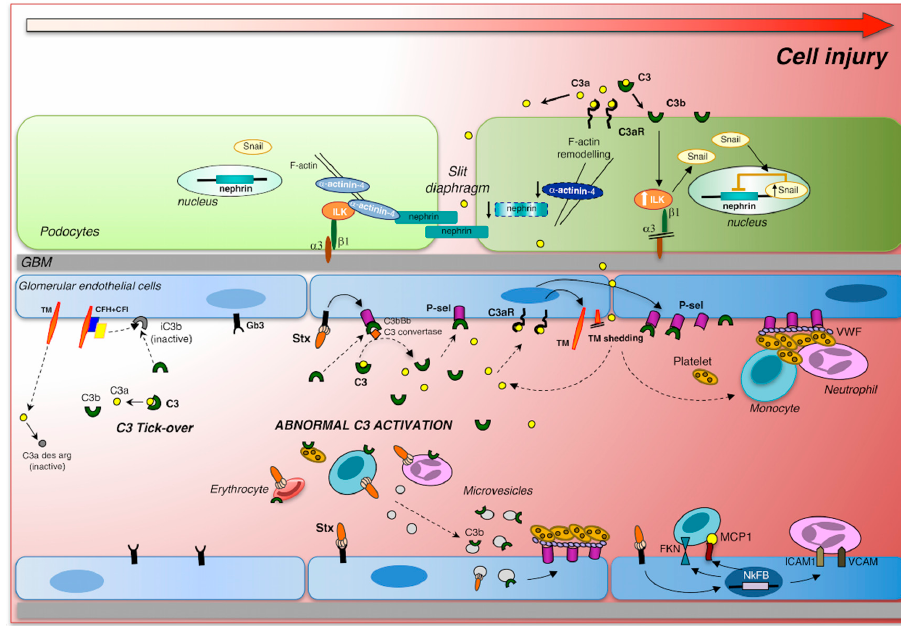
Figure 1. Intracellular signaling triggered by Shiga toxin (Stx) and complement activation in glomerular endothelial cells and podocytes. Stx binds to its specific Gb3 receptor and alters glomerular endothelial cell thromboresistance triggering a cascade of events that lead to microvascular thrombosis. Stx induces the release of thrombomodulin (TM) from the endothelial cell surface and upregulates the expression of P-selectin (P-sel), which interacts with von Willebrand Factor (VWF), thus promoting thrombus formation. Excessive glomerular complement activation and C3 deposition, in response to Stx, generates local C3a that, by binding C3a receptor, further enhances thrombomodulin shedding and P-selectin expression on endothelial cells, thereby favoring complement activation. In the systemic circulation, Stx can bind to neutrophils, monocytes, erythrocytes, and platelets, which in turn release microvescicles with surface-bound C3 that can contribute to the prothrombotic state in STEC-HUS. Stx, via NF- κ B, directly induces the expression and production of MCP-1 and fractalkine (FKN), which, together with the adhesion molecules ICAM- 1 and VCAM-1, favor leukocyte recruitment and adhesion to endothelial cells. In parallel, the C3a fragments in the systemic circulation can cross the glomerular filtration barrier or can be locally generated during C3 activation in the Bowman’s space in the proximity of podocytes. The binding of C3a to C3aR on the podocyte surface causes phenotypic changes including the reduction of α -actinin- 4 expression and the increase of ILK-dependent nuclear translocation of Snail, with consequent nephrin downregulation and podocyte dysfunction and detachment. Adapted from Zoja et al, 2017 [63]. 4. The Complement System A large body of evidence collected over the last three decades shows that complement activation contributes to the pathophysiology of STEC-HUS [63–66]. The complement system was discovered approximately 100 years ago, as a group of heat-sensitive plasmatic proteins that enhance the opsonization and elimination of bacteria by antibodies with a function complementary to that of humoral immunity . Nowadays, complement should instead be considered as a system that links several responses during immune and inflammatory reactions, and not merely as a bacterial killer [67]. The complement system comprises over 30 components, including membrane-bound regulators, receptors, and numerous plasma proteins. Complement (C) is activated through the classical, lectin, or alternative pathways [68]. The activation of the classical pathway starts by the